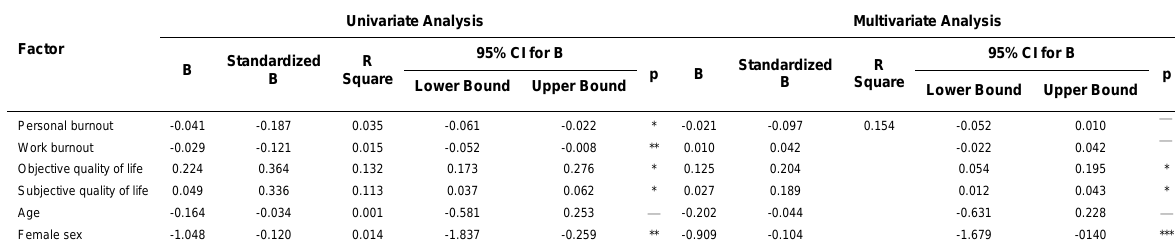
Regression Analysis of Impact of Burnout, Quality of Life, Age, and Sex on Work Ability